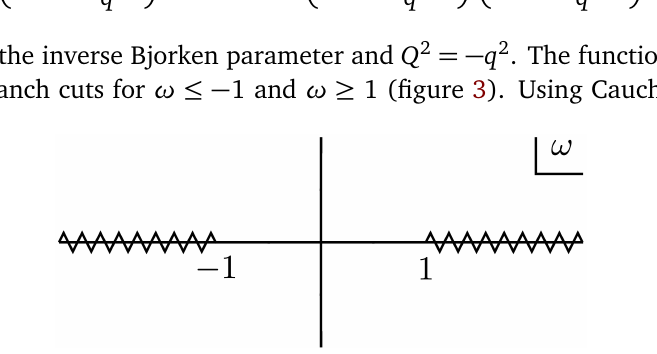
( ω , Q 2 ) and T ( ω , Q 2 ) have branch cuts for ω ≤ − 1 and 1 2